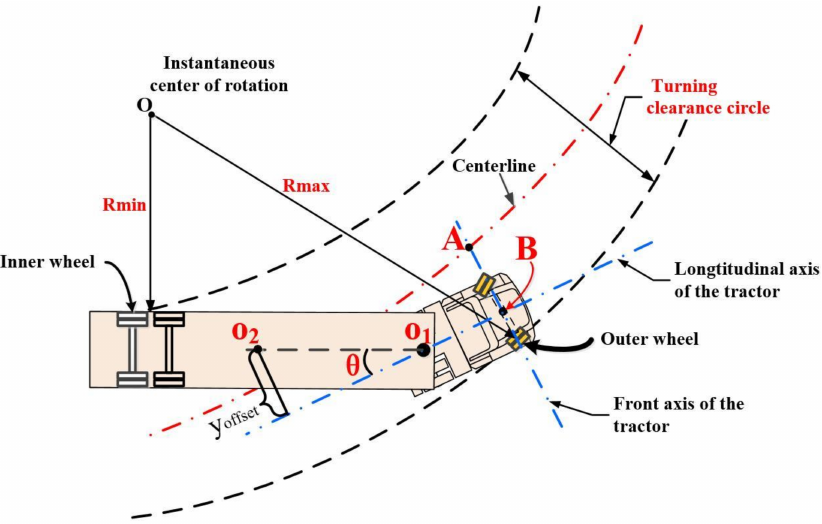
Figure 3. Steering kinematics model of a